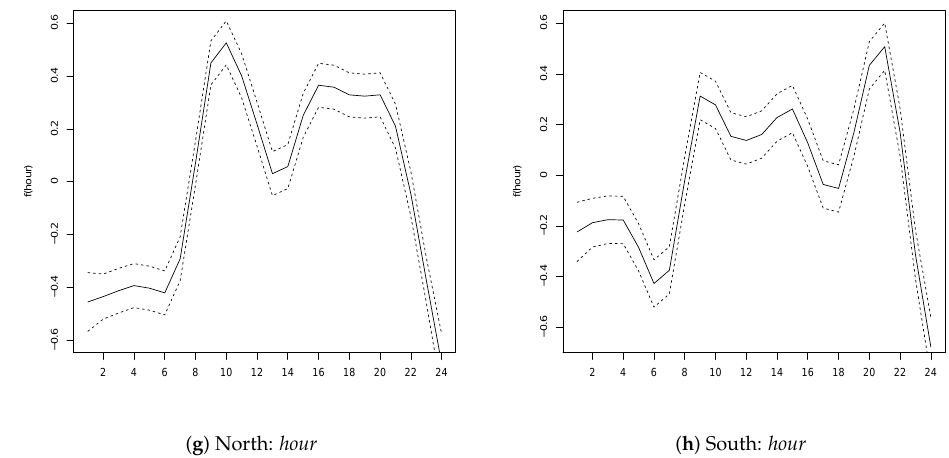
Figure 5. In-sample estimation results of the non-parametric additive model for the conditional variance of electricity prices. For both zones, each panel plots the estimated function h j ( · ) for the calendar effects and the overall trend.